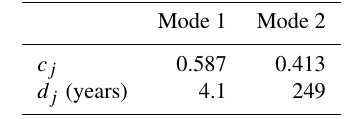
Table 1. Constants of the Geoffroy et al. (2013)